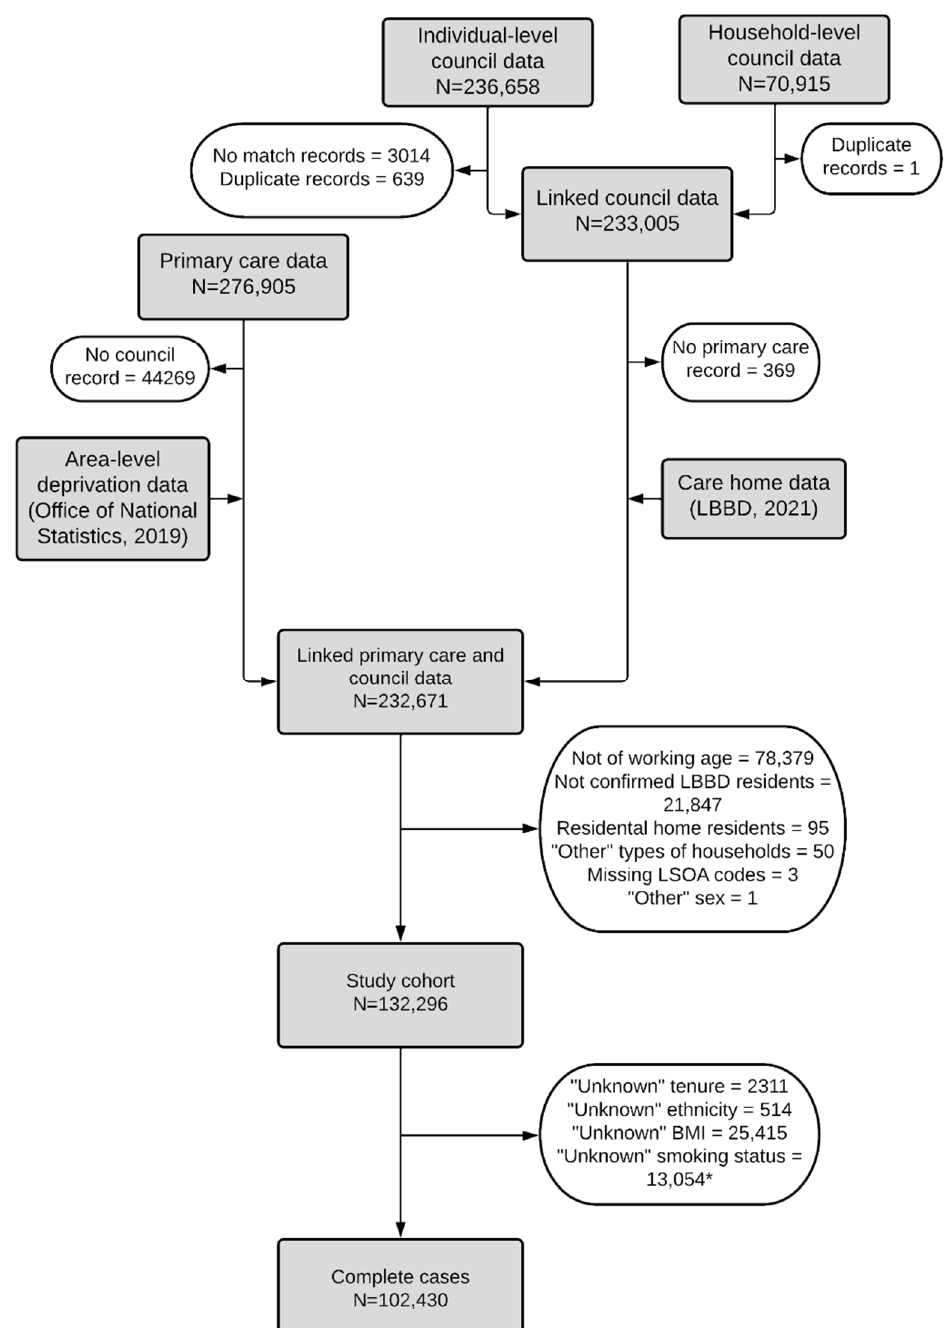
Figure A1. Results of data linkages. * Number of participants with missing data on each variable sum to greater than 29,866 (132,296 minus 102,430) as some participants had missing data across more than one variable.